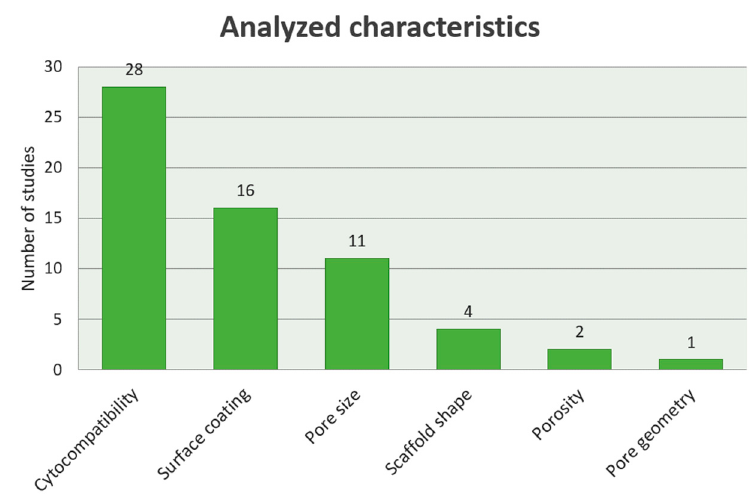
Figure 5. Synthesis of the number of studies that analysed different characteristics in the studies.